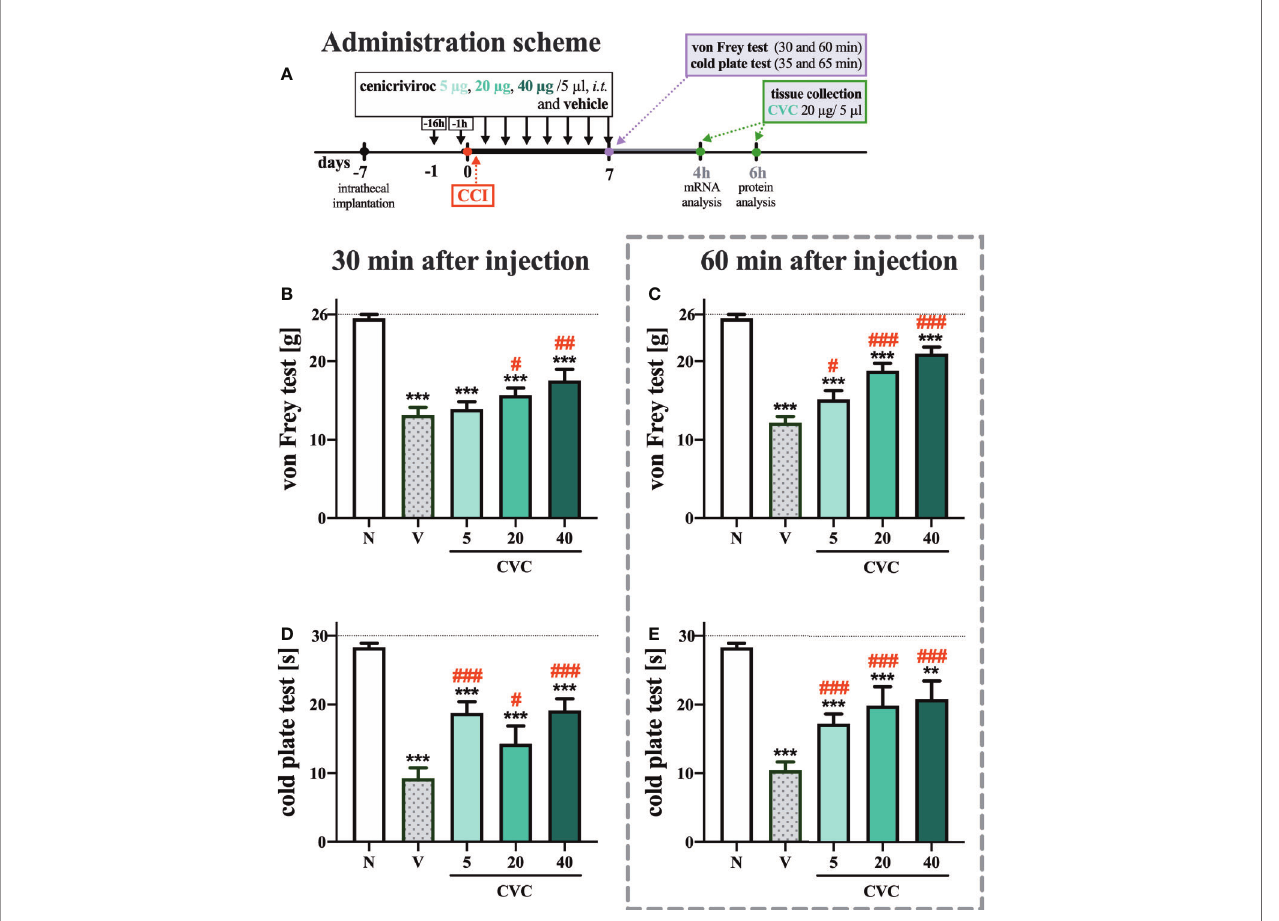
FIGURE 1 | Dose-dependent changes following the preemptive (16 h and 1 h before CCI) and then repeated i.t. administration of cenicriviroc in concentrations of 5 µg, 20 µg, and 40 µg/5 µl [ (A) administration scheme] on pain-related behaviors [ (B, C) von Frey test; (D, E) cold plate test] on day 7 post CCI, 30 min or 60 min after cenicriviroc or vehicle injection. Data are presented as the mean ± SEM (n = 7 – 10 per group). Intergroup differences were analyzed by ANOVA with Bonferroni ’ s multiple comparisons test. ***p < 0.0001, **p < 0.01 indicates differences between naive and CCI-exposed rats; ### p < 0.001, ## p < 0.01, # p < 0.05 indicates differences between V-treated and CVC-treated CCI-exposed rats. The dotted line shows the cut-off value. CCI, chronic constriction injury; CVC, cenicriviroc; N, naive; V,